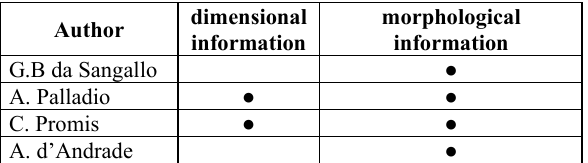
Table 1 . dimensional and morphological information from different drawings.